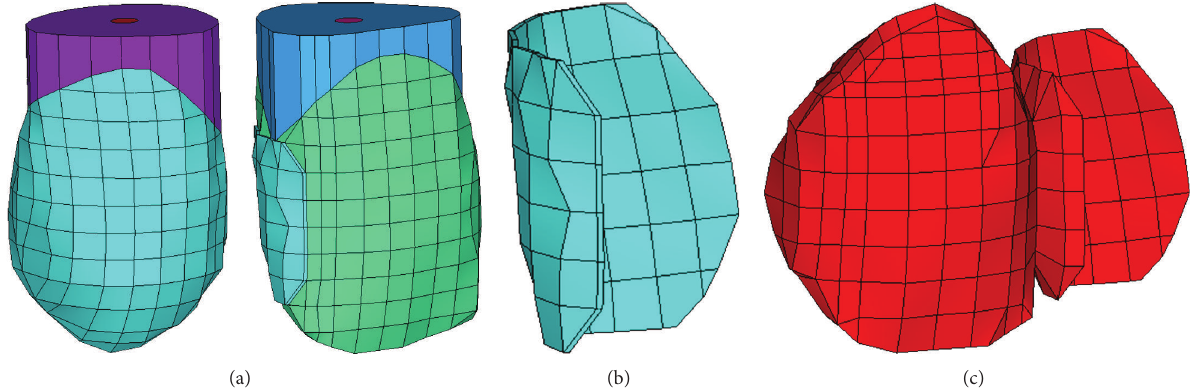
Figure 1: 3D FE model of a cantilever two-unit RBFDP: (a) abutment and adjacent tooth, (b) cement layer, and (c)